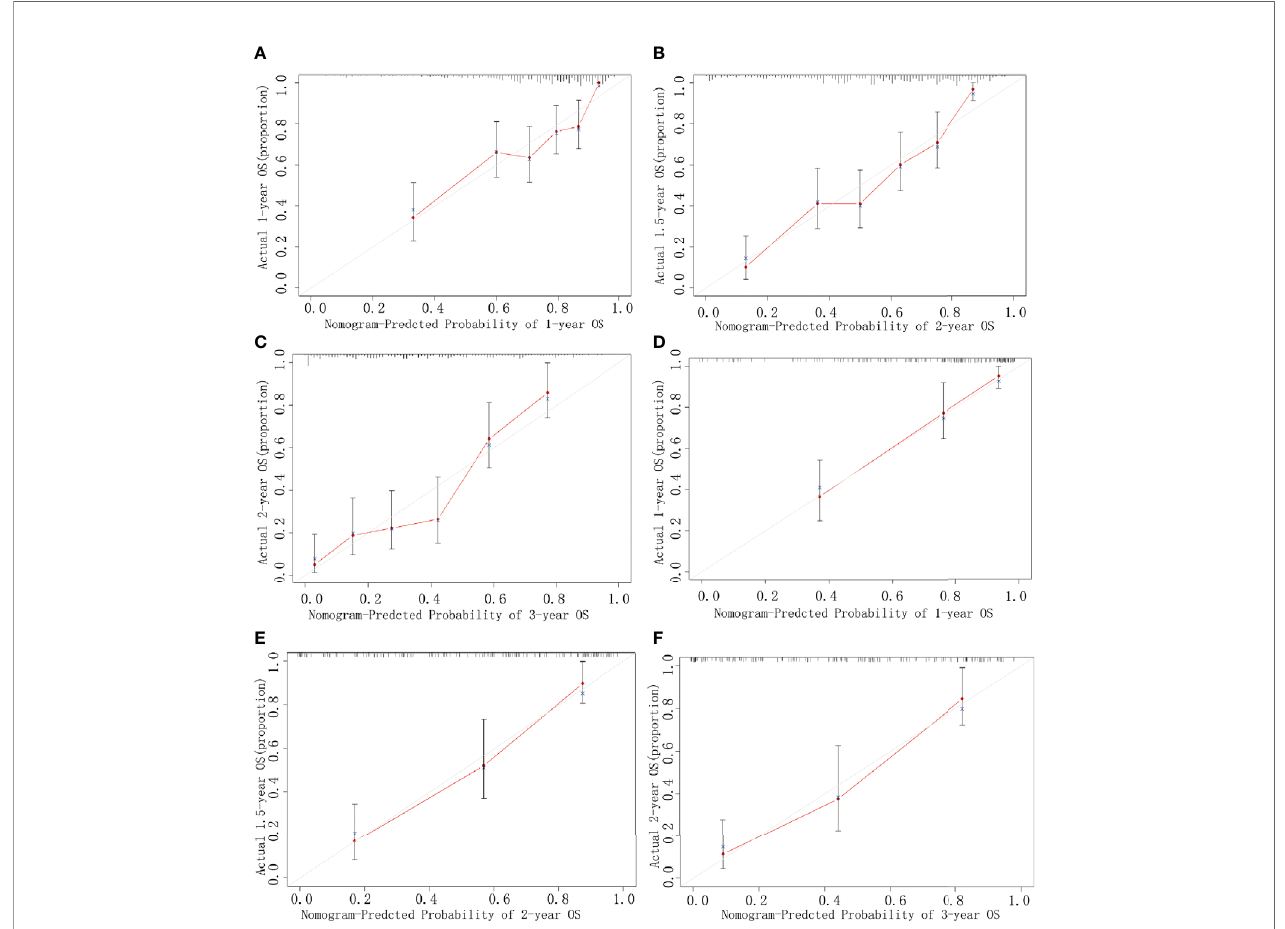
FIGURE 3 | Calibration curves. Curves for 1-year (A) , 2-year (B) , and 3-year (C) OS in the training cohort, and those for 1-year (D) , 2-year (E) , and 3-year (F) OS in the validation cohort. The predicted possibility of the year-speci fi c OS rate is indicated in the x -axis, and the actual possibility of the year-speci fi c OS rate is indicated in the y